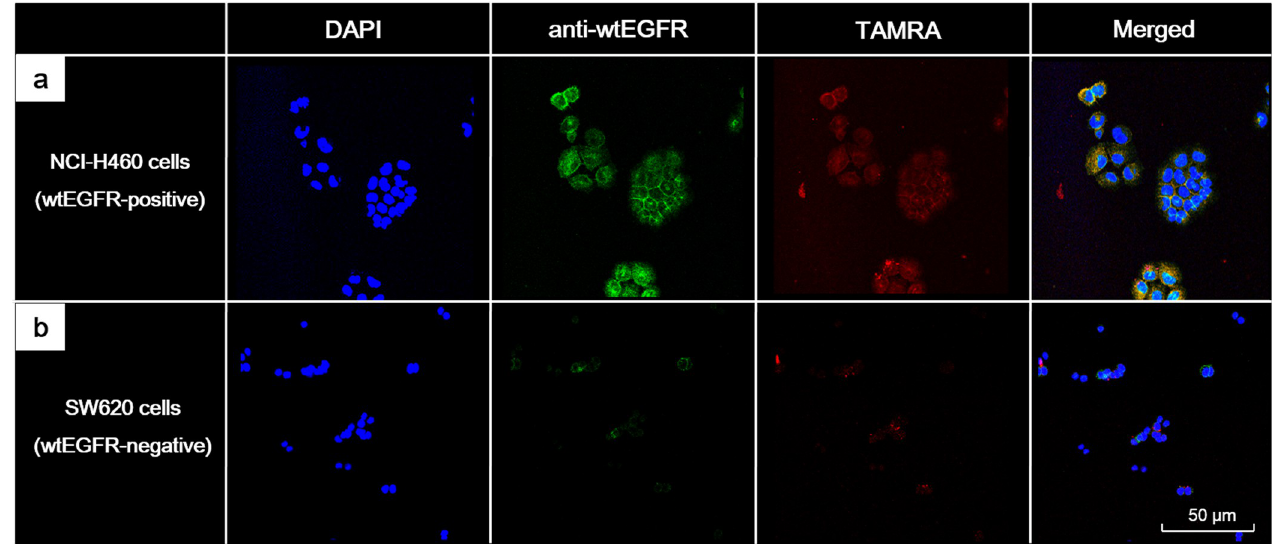
Fig 3. (a) Confocal microscopy images of wtEGFR-positive NCI-H460 cells incubated with Tc-99m SYPIPDT-ECG-TAMRA showed strong fluorescence activity (red) on the cell membrane. On the merged image of DAPI (blue), anti-wtEGFR (green) and SYPIPDT-ECG-TAMRA (red) channels, the TAMRA activity could be correlated with anti-wtEGFR activity. (b) In contrast, the fluorescence activities of SYPIPDT-ECG-TAMRA (red) and anti-wtEGFR (green) were barely detectable in wtEGFR-negative SW620 cells.